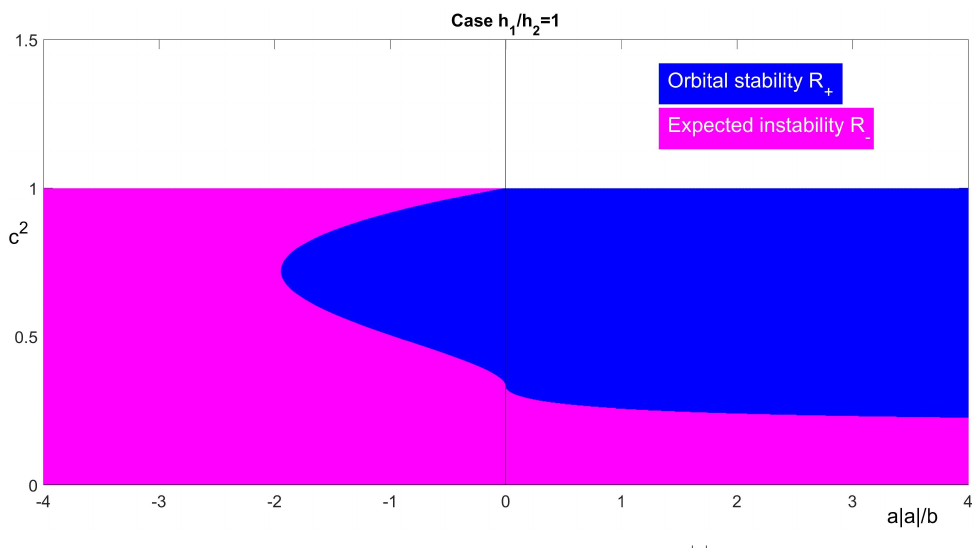
∈ ( − 4,4 ) and c 2 ∈ ( 0,1 ) : b